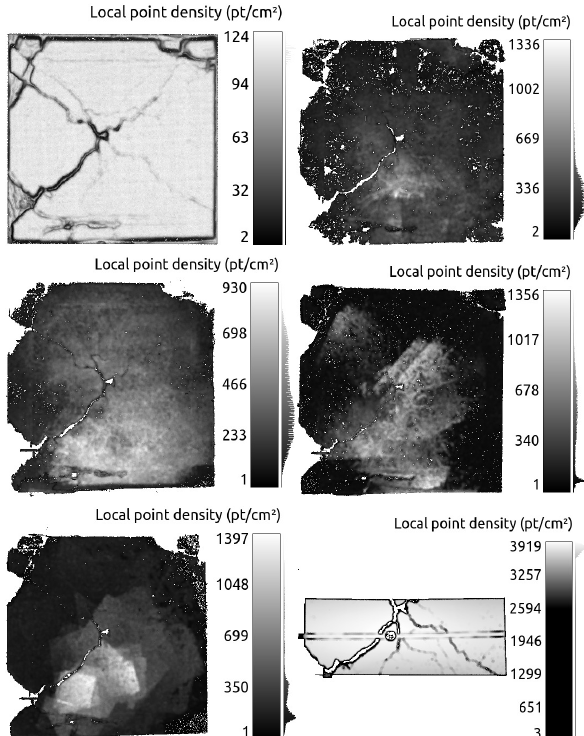
Figure 12. Local point density comparison of the point clouds from the different sensors: PPS-Plus (upper left), S8 (upper right), Fuji shadow (center left), Fuji sun (center right), G-419B (bottom left), and Sick Ranger3 (bottom right).